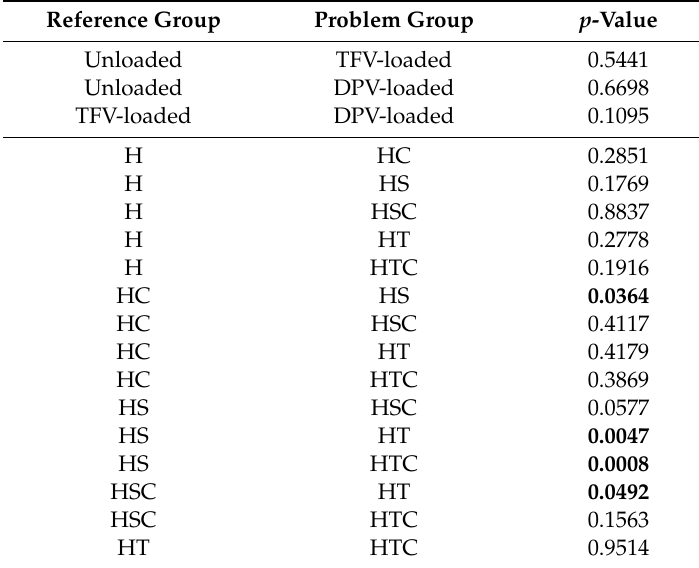
Table 4. p -Values obtained in the comparison of the group of batches by paired t-test. Significant differences are in bold.